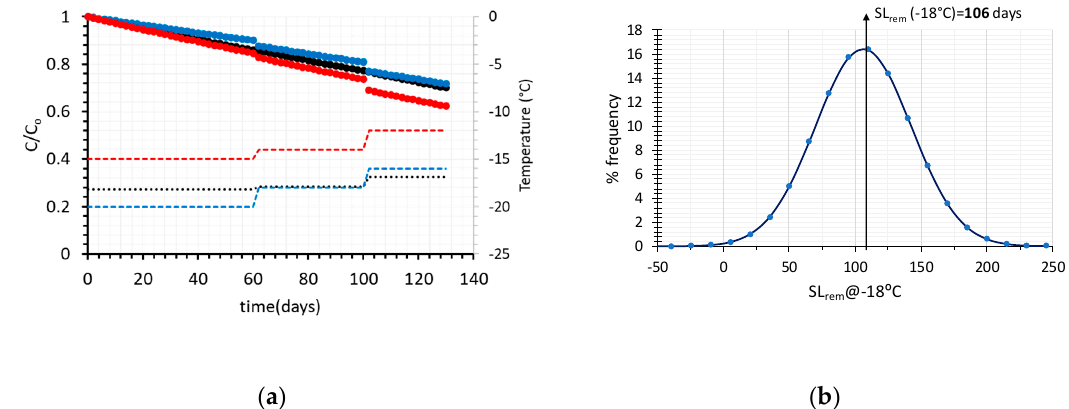
Figure 4. ( a ) Vitamin C degradation, for different temperature scenarios of the cold chain of frozen green peas (black line represent the C/Co value for the average temperatures of all stages) and ( b ) Remaining Shelf Life estimated at a reference temperature of − 18 °C, for the 2000 different distribution scenarios through Monte Carlo technique (kinetic parameters E a -k ref in Equation (6) assumed fixed).